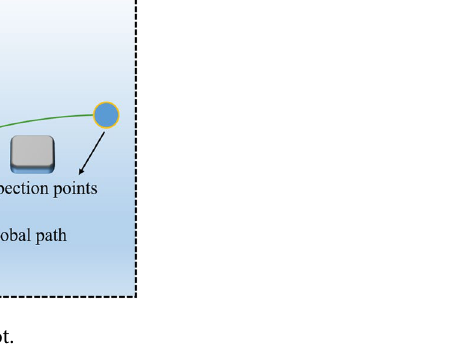
Figure 1. Work overview of weld inspection